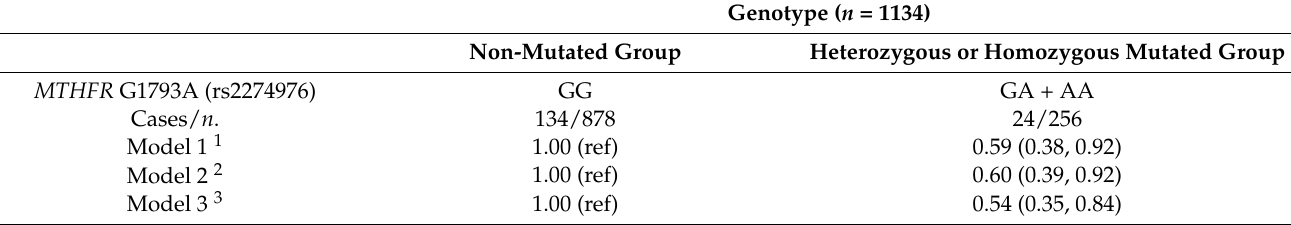
Table 3. Hazard ratios (HRs) and 95% confidence intervals (CIs) of type 2 diabetes according to genotype of five selected genetic variants ( n =